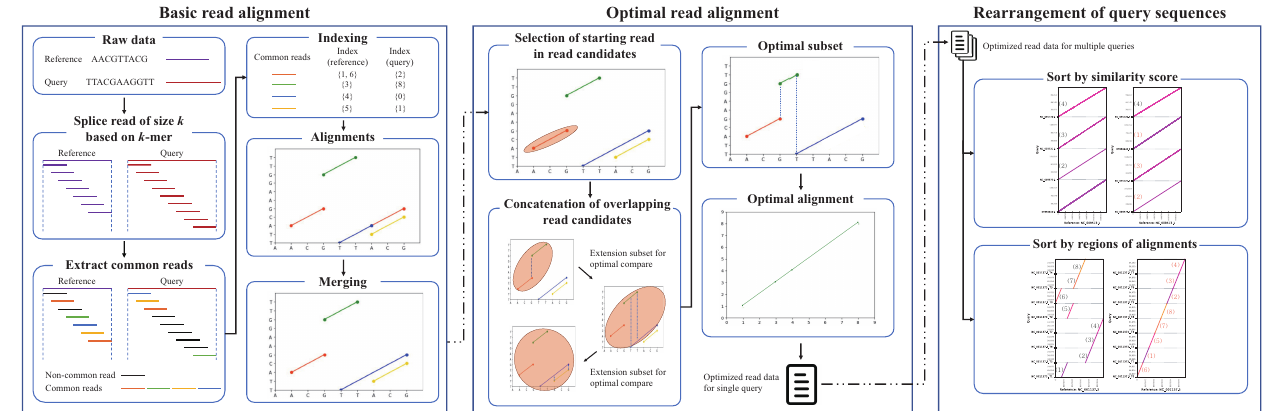
Figure 5. Overview of the cPlot